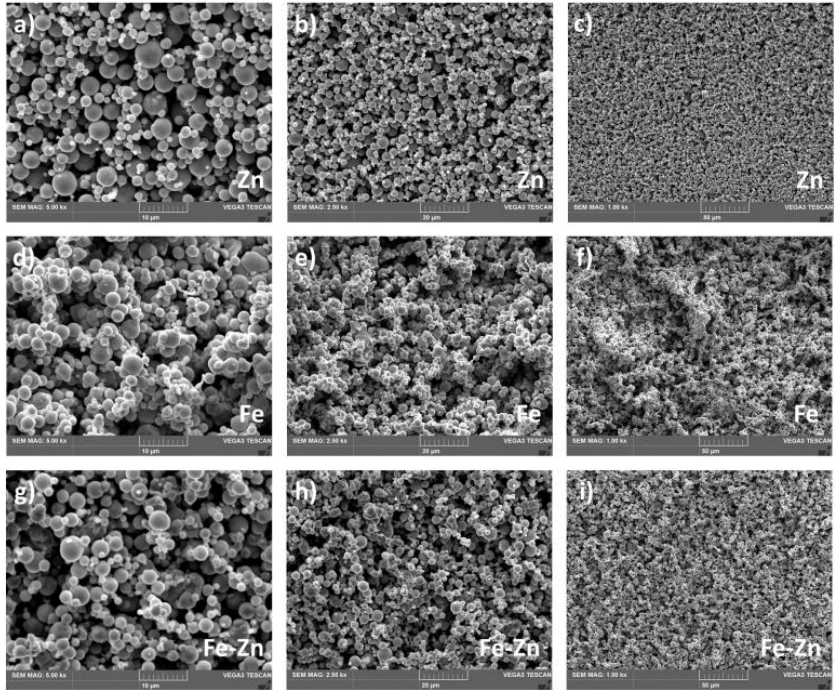
Figure 1. SEM micrographs of Zn ( a – c ), Fe ( d – f ) and Fe-Zn ( g – i ) powders at 5000 × , 2500 × and 1000 × magnification.